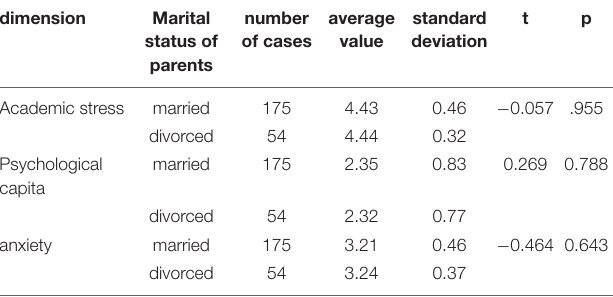
TABLE 9 | Is the difference test result on academic stress, psychological capital and anxiety of whether an only child. Dimension